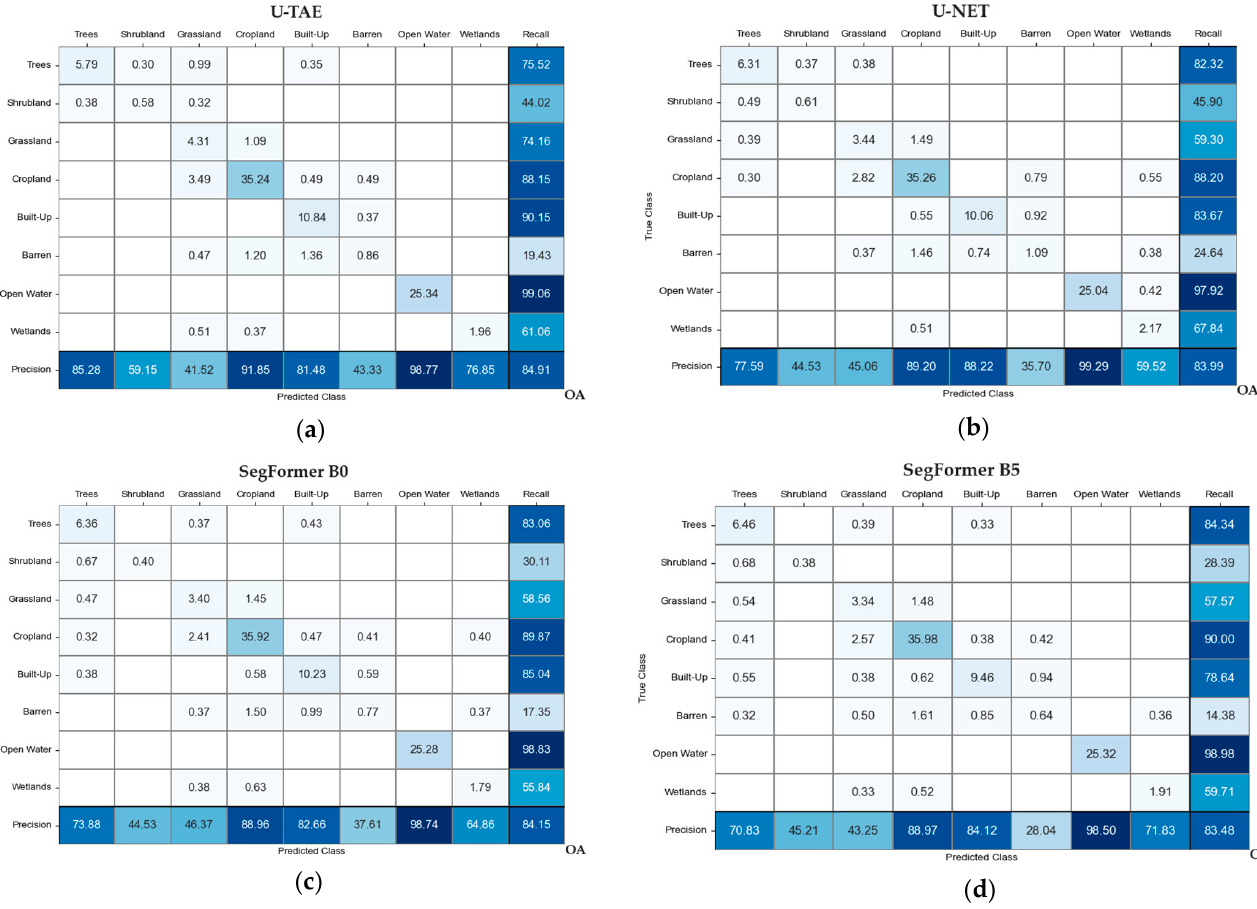
Figure 6. From left to right, top to bottom. Confusion matrices for the best models of ( a ) SegFormer B0, ( b ) SegFormer B5, ( c ) U-NET, and ( d ) U-TAE. The last row is the class precision, and the last column is the class recall. Percents smaller than 0.3% are omi tt ed for clarity.